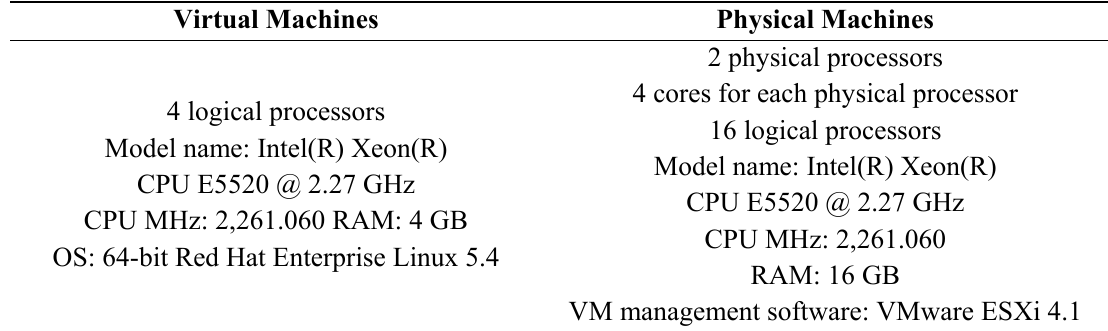
Table 1. The configurations of virtual and physical machines.